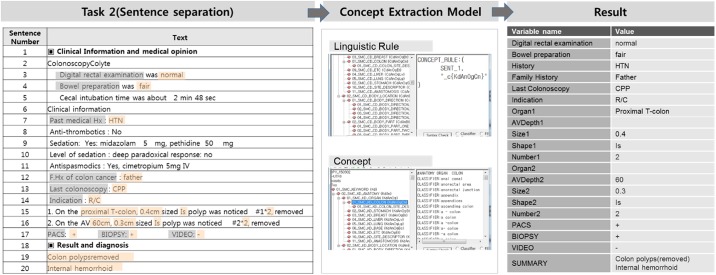
Concept extraction process.